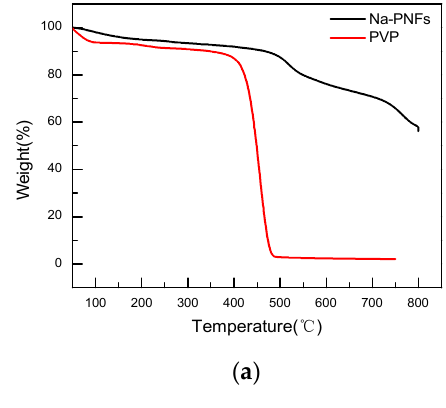
Figure 9. ( a ) TGA curves of Na-PNFS and PVP under nitrogen atmosphere; ( b ) Raman spectra of Na-PNFS and PVP residue after annealing at 900 ◦ C for 2 h in nitrogen atmosphere. The oxidation of copper nanoparticles can be observed through the weight gain of the sample during oxidation [29]. TGA shows that the Cu@organic were stable until 175 ◦ C, as no weight gain occurred before this temperature, while the Cu@MC were stable up to 250 ◦ C. The weight gain of Cu@organic at 550 ◦ C was 20%, and Cu@MC at 550 ◦ C was 10% (Figure 10). The increased stability suggests that the carbon layer provides good protection for the copper nanoparticles from oxidation.